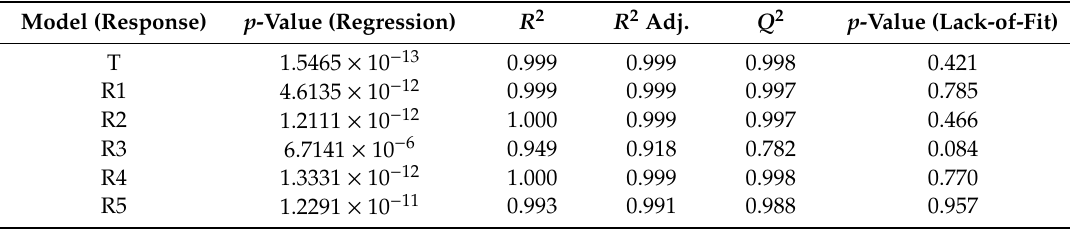
Table 4. Statistical parameters of mathematical models obtained with response-surface